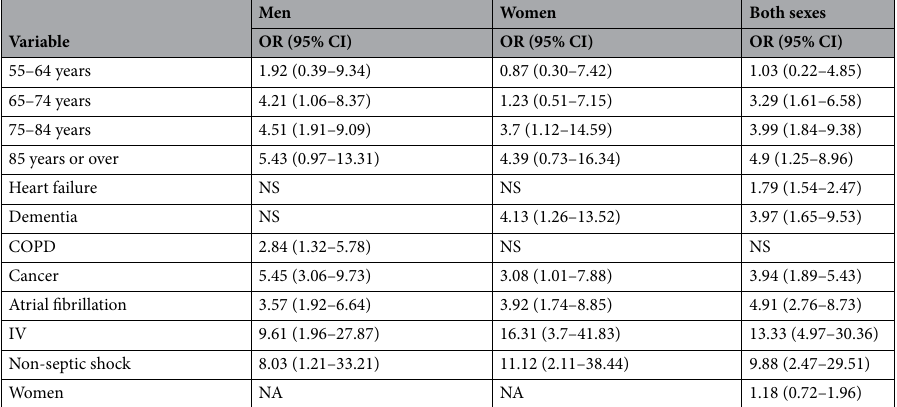
Table 5. Multivariable analysis using logistic regression to identify variables associated with in-hospital mortality for patients hospitalized with pulmonary embolism (PE) and obstructive sleep apnea (OSA) according to sex in Spain from year 2016 to year 2018. COPD Chronic obstructive pulmonary disease, IV invasive ventilation, OR Odds ratio, CI confidence interval, NA not applicable, NS not